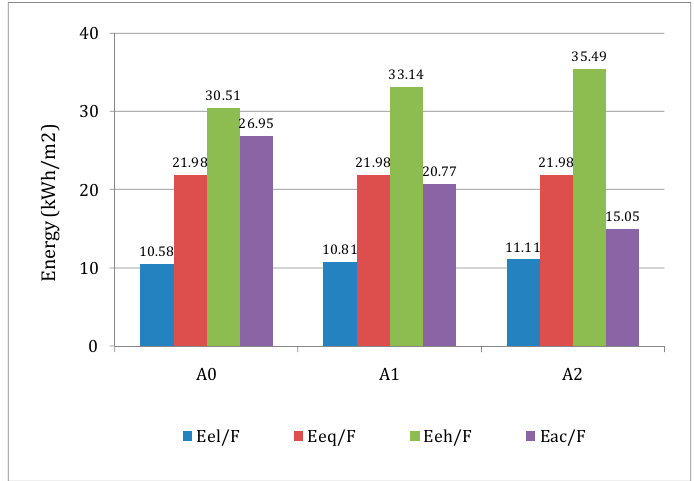
Figure 8. Specific final energy consumption for lighting, electric equipment, heating and cooling in the analyzed buildings.